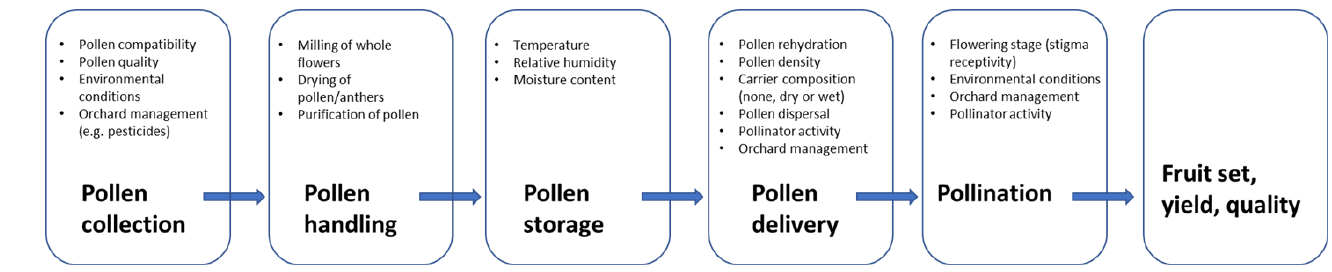
Figure 2. Key steps and factors in mechanical pollination systems (modified from Cacioppo et al., 2018 [58]).